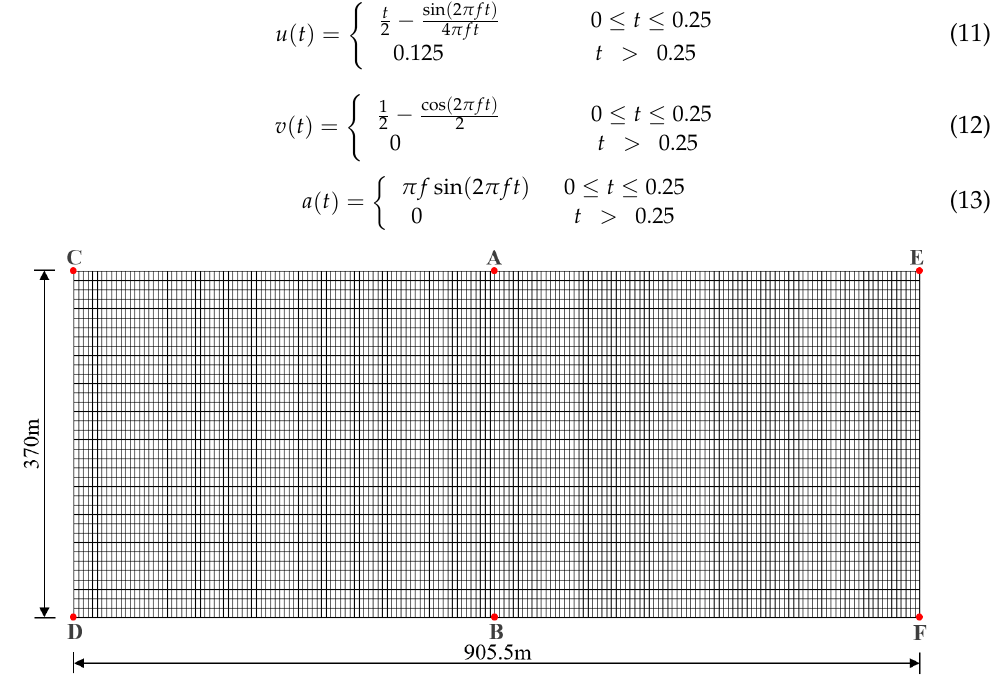
Figure 3. The finite element model of the verification test.